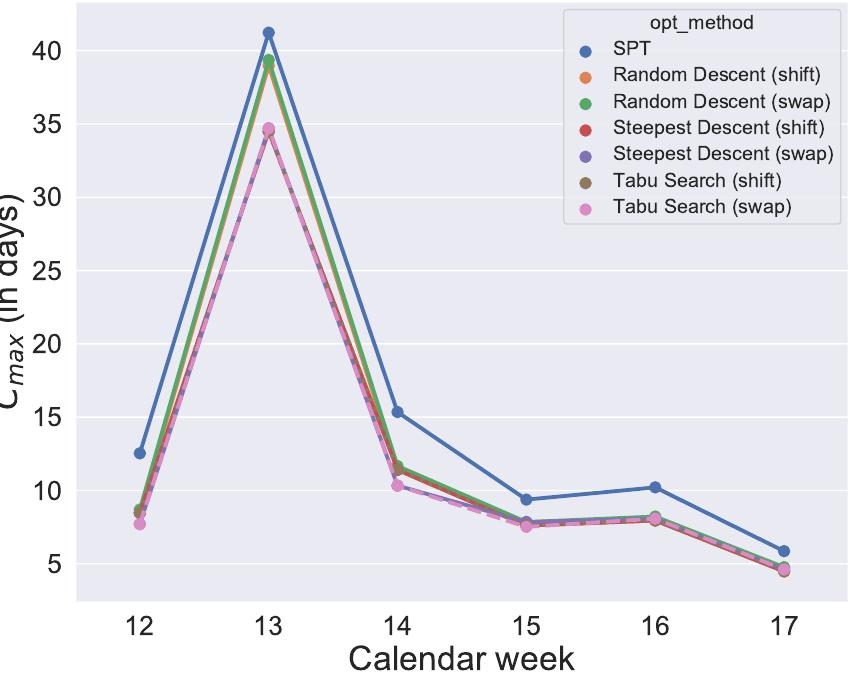
Figure 12. Optimization results for quantile 91%.